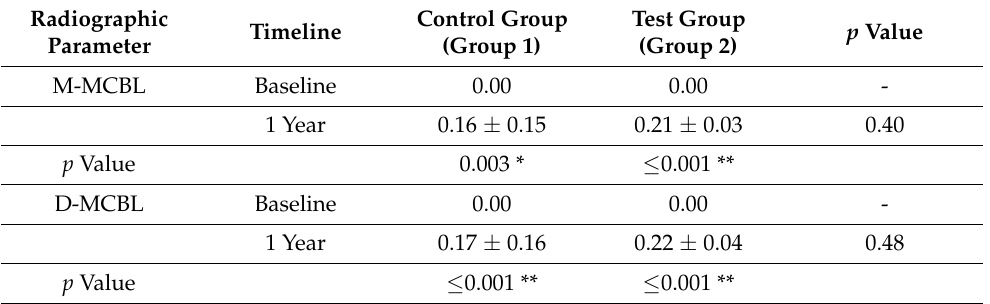
Table 4. Intra- and intergroup comparison of crestal bone loss.